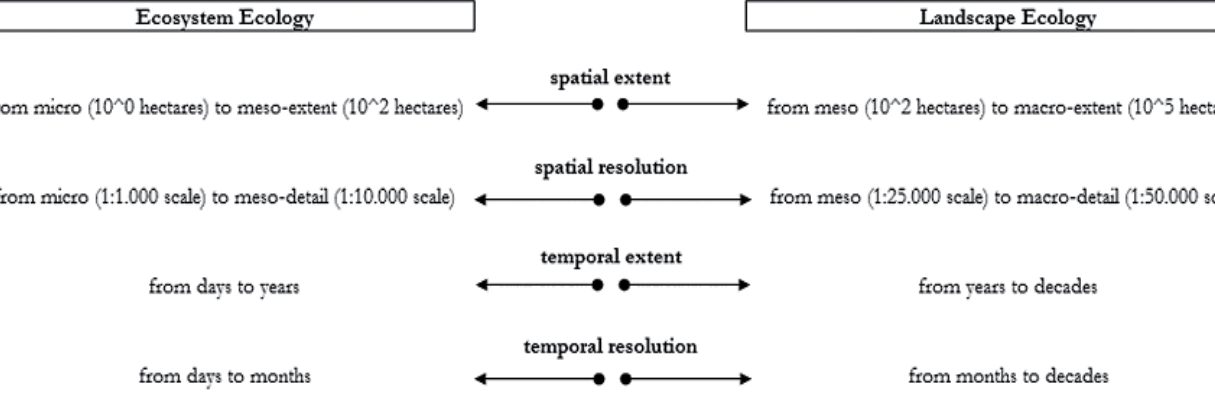
Figure 1: Schematic comparison between ecosystem and landscape ecology along time and